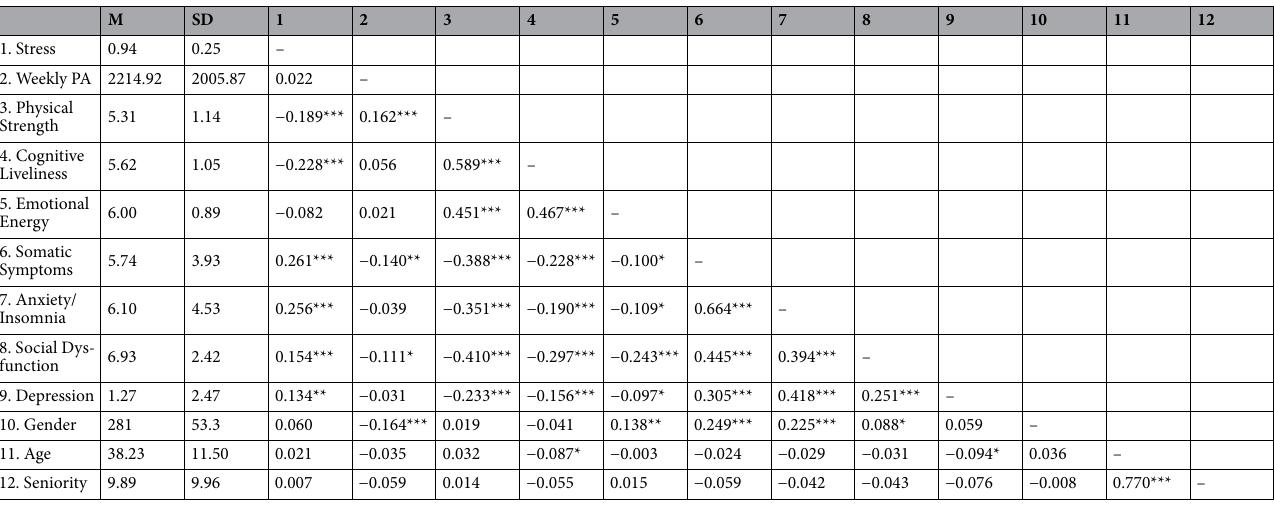
Table 1. Mean scores, standard deviations and Pearson correlations. Seniority = number of years as worker in the organization; Gender, male = 1, female = 2, for gender row, in M and SD are referred to the number